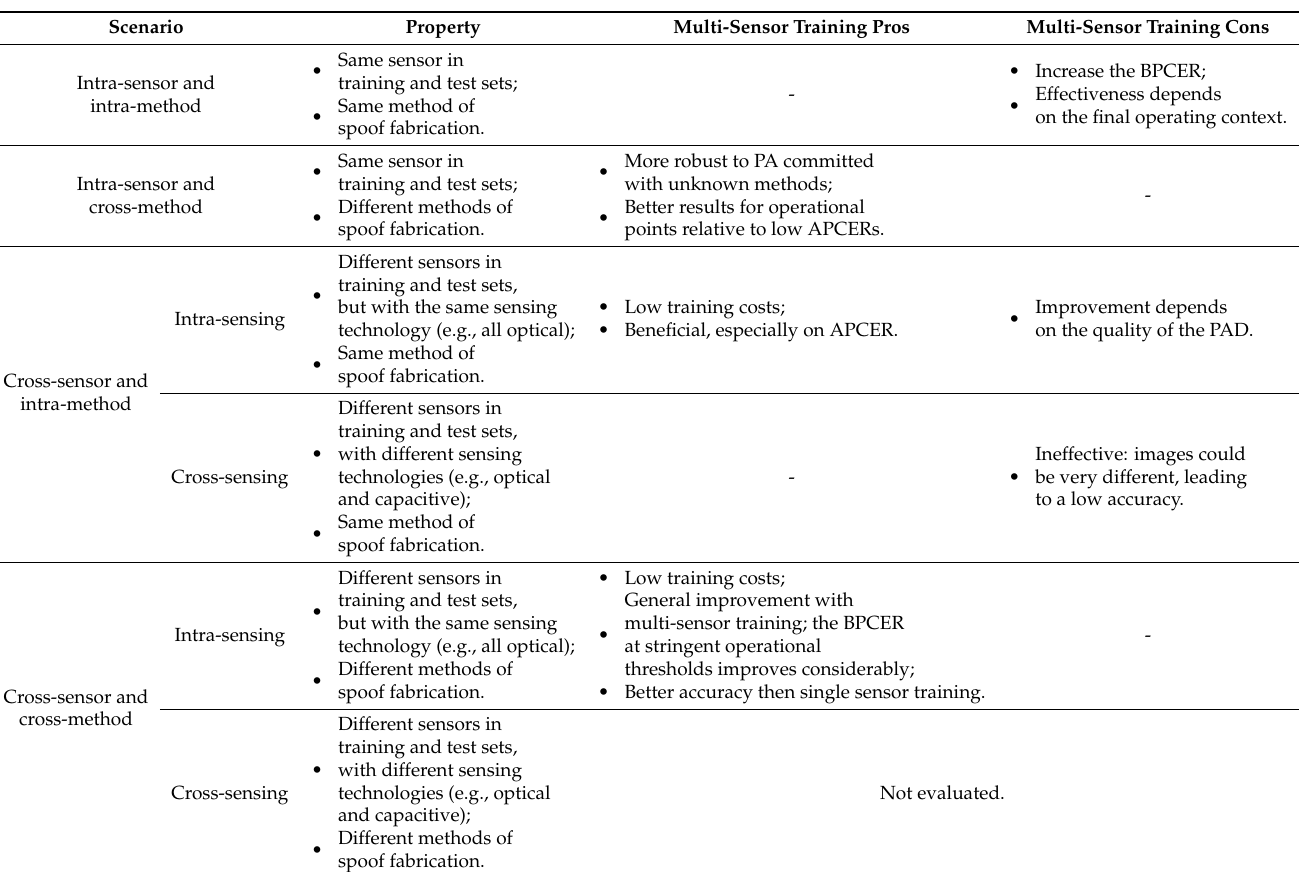
Table 12. Pros and cons of training on data acquired with multiple sensors for the investigated